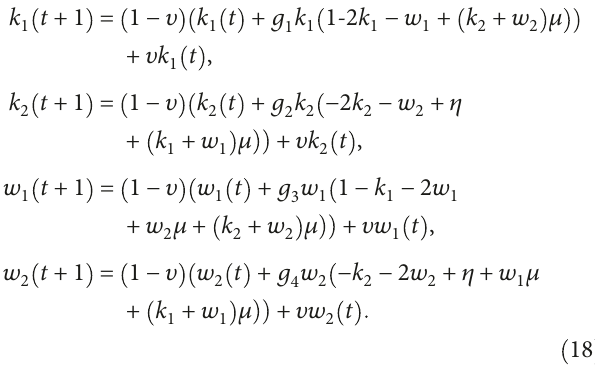
1 in a chaotic state.